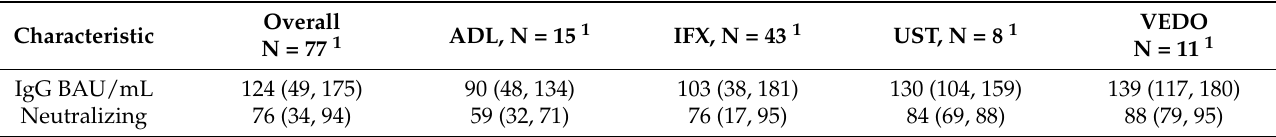
Figure 1. Box plot illustrating IgG antibody concentrations among patients on different biologic therapies. Table 2. Serological response in participants vaccinated with the BNT162b2 vaccine and receiving biologic therapies.